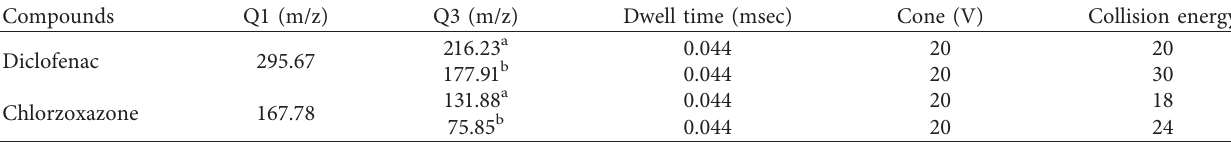
Table 1: The mass scan method parameters of diclofenac and chlorzoxazone (internal standard, IS). Compounds